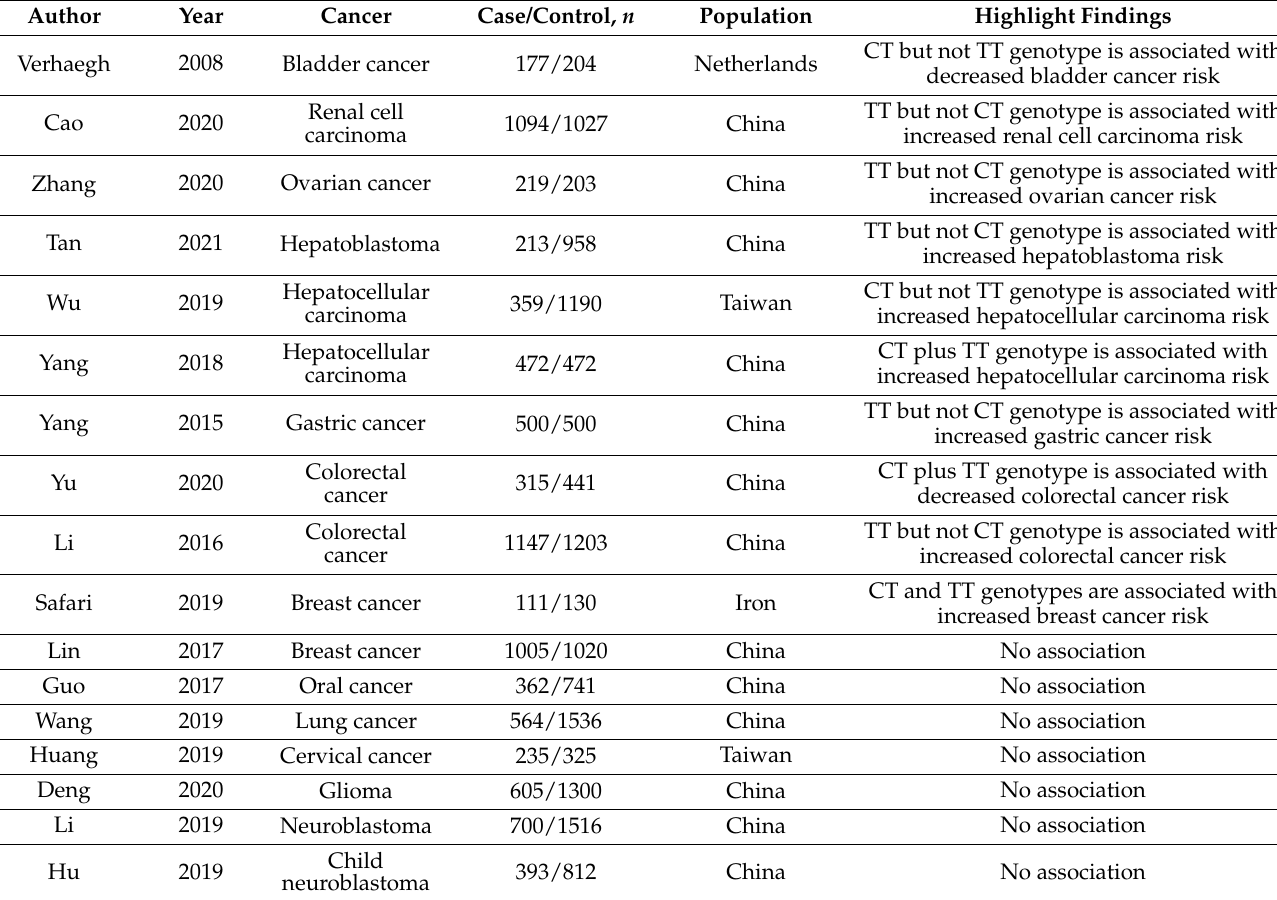
Table 7. The summary of genotypic findings for H19 rs2839698 polymorphism among cancer